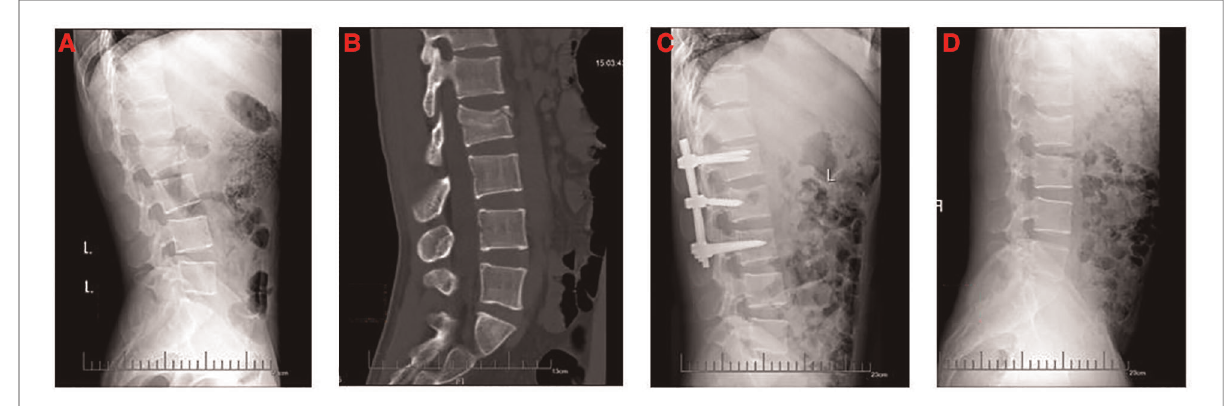
FIGURE 3 The preoperative and postoperative radiographs of six-pedicle screws fi xation with short intermediate pedicle screws group. ( A ) Preoperative lateral x-ray. ( B ) Preoperative lateral computed tomography. ( C ) Lateral x-ray 1 month after surgery. ( D ) Lateral x-ray at fi nal